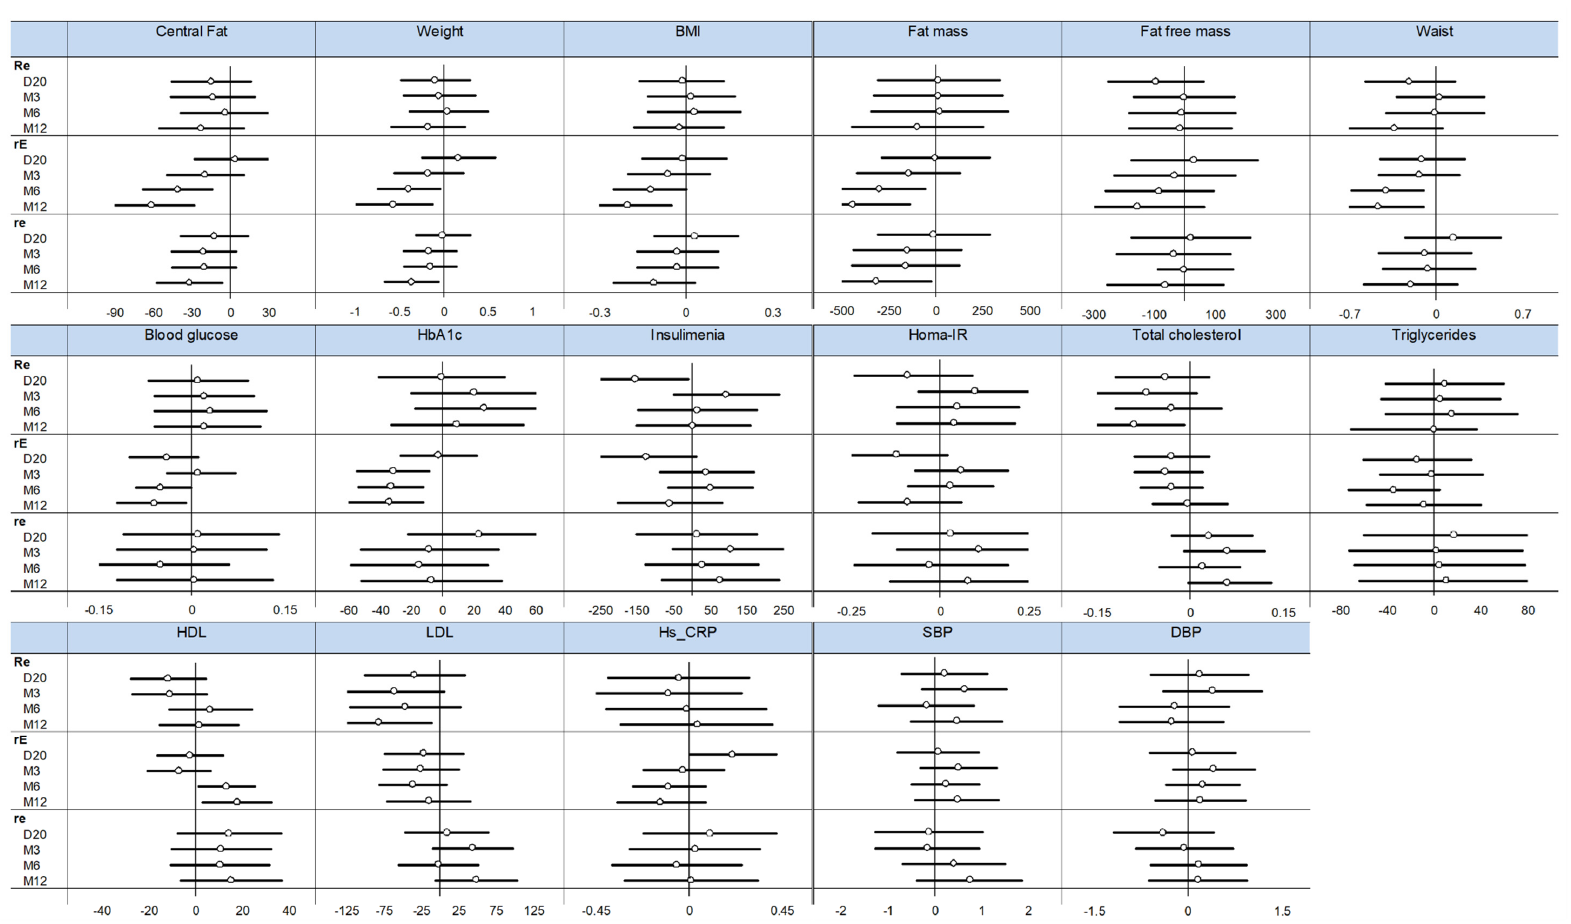
Figure 3. Effect of fiber intake on health outcomes depending on time and group—Forest plots represent effect sizes (dot) and their 95% confidence intervals (horizontal lines on both sides). For details, please see Table S2. HbA1c: glycated haemoglobin; Homa-IR: Homeostatic Model Assessment of Insulin Resistance, HDL: high-density lipoprotein, LDL: low-density lipoprotein, Hs-CRP: high-sensitivity c-reactive protein. BMI: Body Mass Index. SBP: systolic blood pressure; DBP: diastolic blood pressure. Re, rE and re: see methods for details. D: day; M: month.